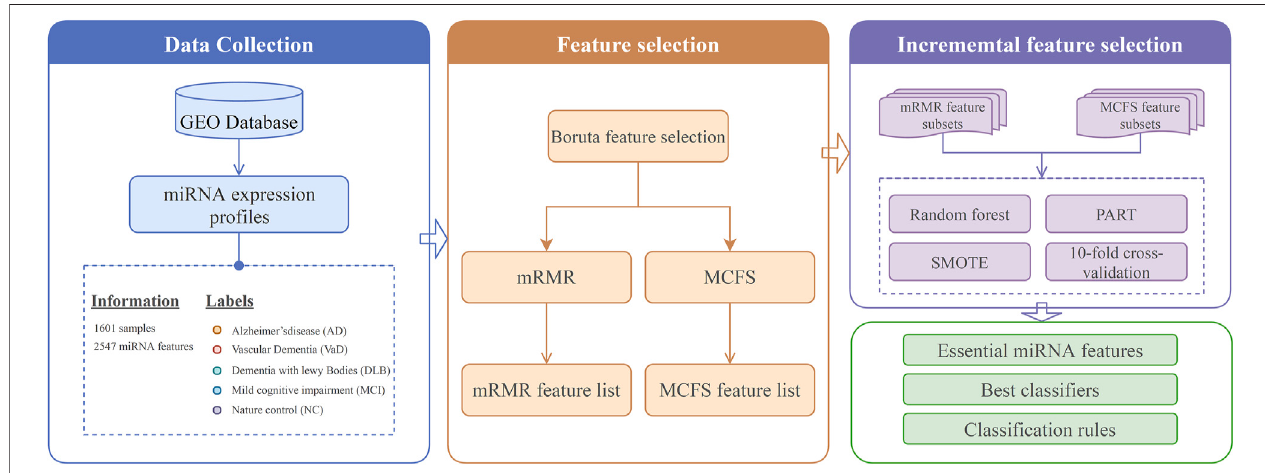
FIGURE 1 | Analysis fl owchart for this study, which consists of three main steps: 1) miRNA dataset collection; 2) fi ltering and ranking of miRNA features in the dataset using Boruta, mRMR,and MCFS; 3) determining theessentialmiRNAfeatures and building thebest classi fi ers and classi fi cation rules using IFSmethodwith RF and PART algorithms.